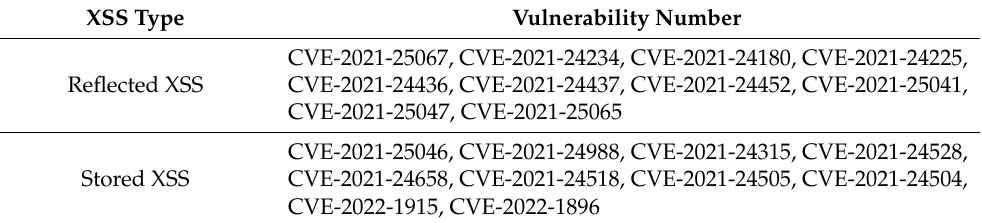
Table 1. CVE list.